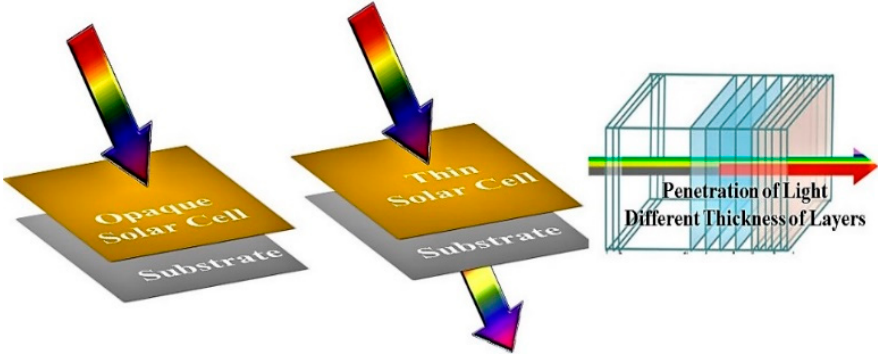
Figure 5. Schematic representation of the transparency of light, indicating the thickness of the different layer of a PSC.